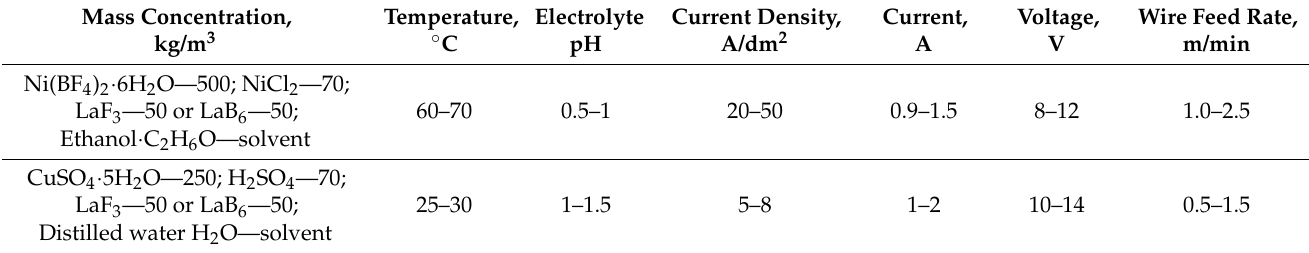
Table 2. Parameters of the electrochemical process and electrolyte composition.